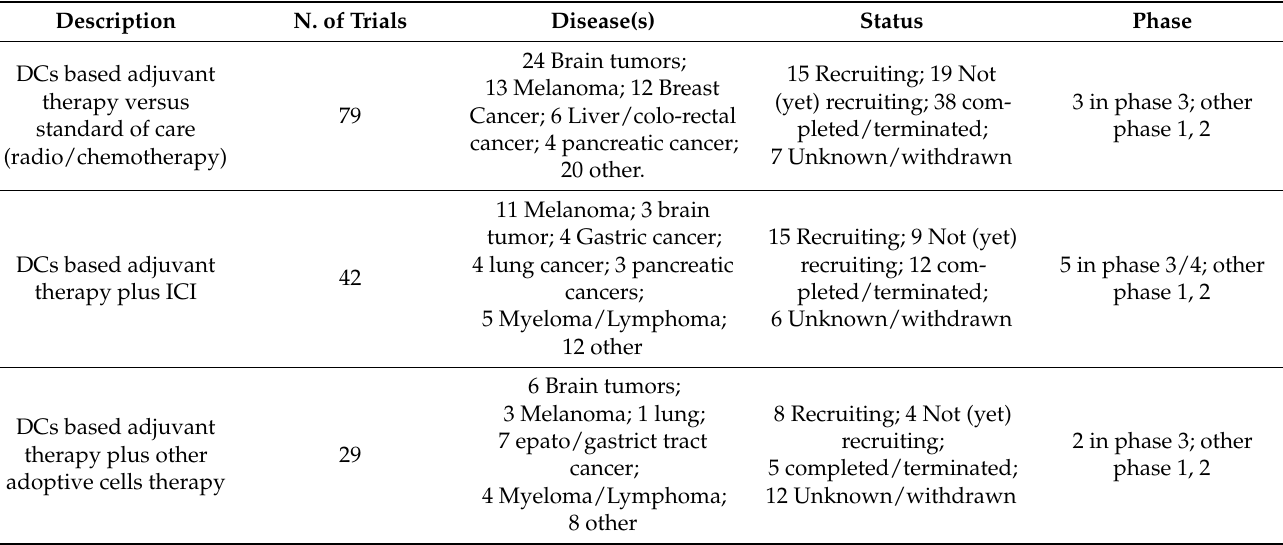
Table 1. Adjuvant Dendritic Cell Immunotherapy trials for cancer